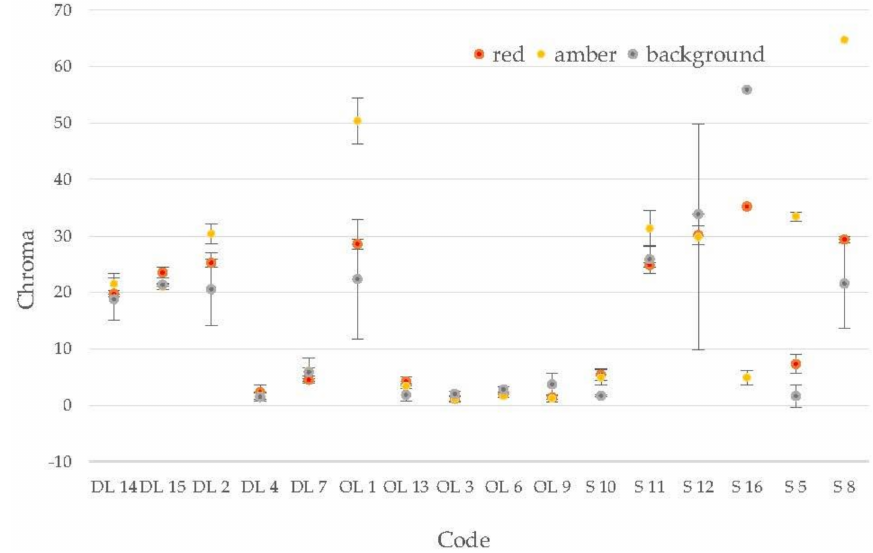
Figure 8. Average of chroma values per color for all the prints.